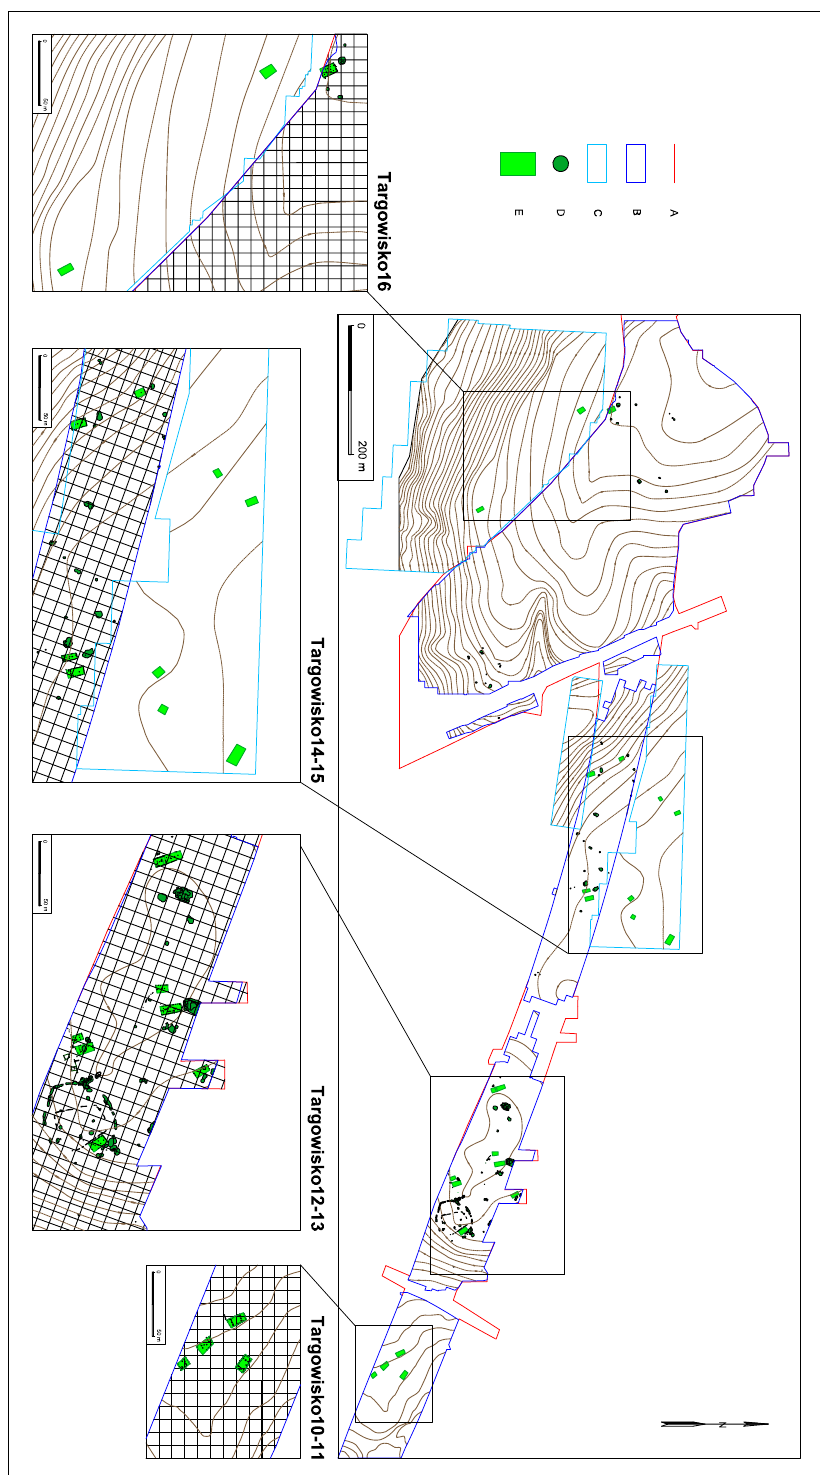
Figure 3: Spatial distribution of MC houses in Targowisko ( sites 10 – 16 ) settlement complex: ( a ) boundaries of the unexplored area, ( b ) boundaries of the excavated area, ( c ) boundaries of geomagnetic survey, ( d ) MC features and ( e ) MC houses ( drawn by P. Kalka )